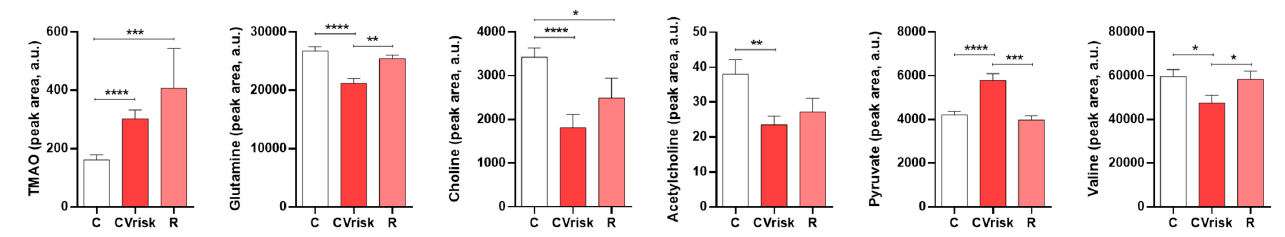
Figure 2. Metabolite abundance in plasma in subjects with programmed bypass surgery (CVrisk group) compared to healthy subjects (C group). Data during clinical follow-up 3 months after Scheme 0. * p value < 0.05, ** p value < 0.01, *** p value < 0.001, **** p value < 0.0001.